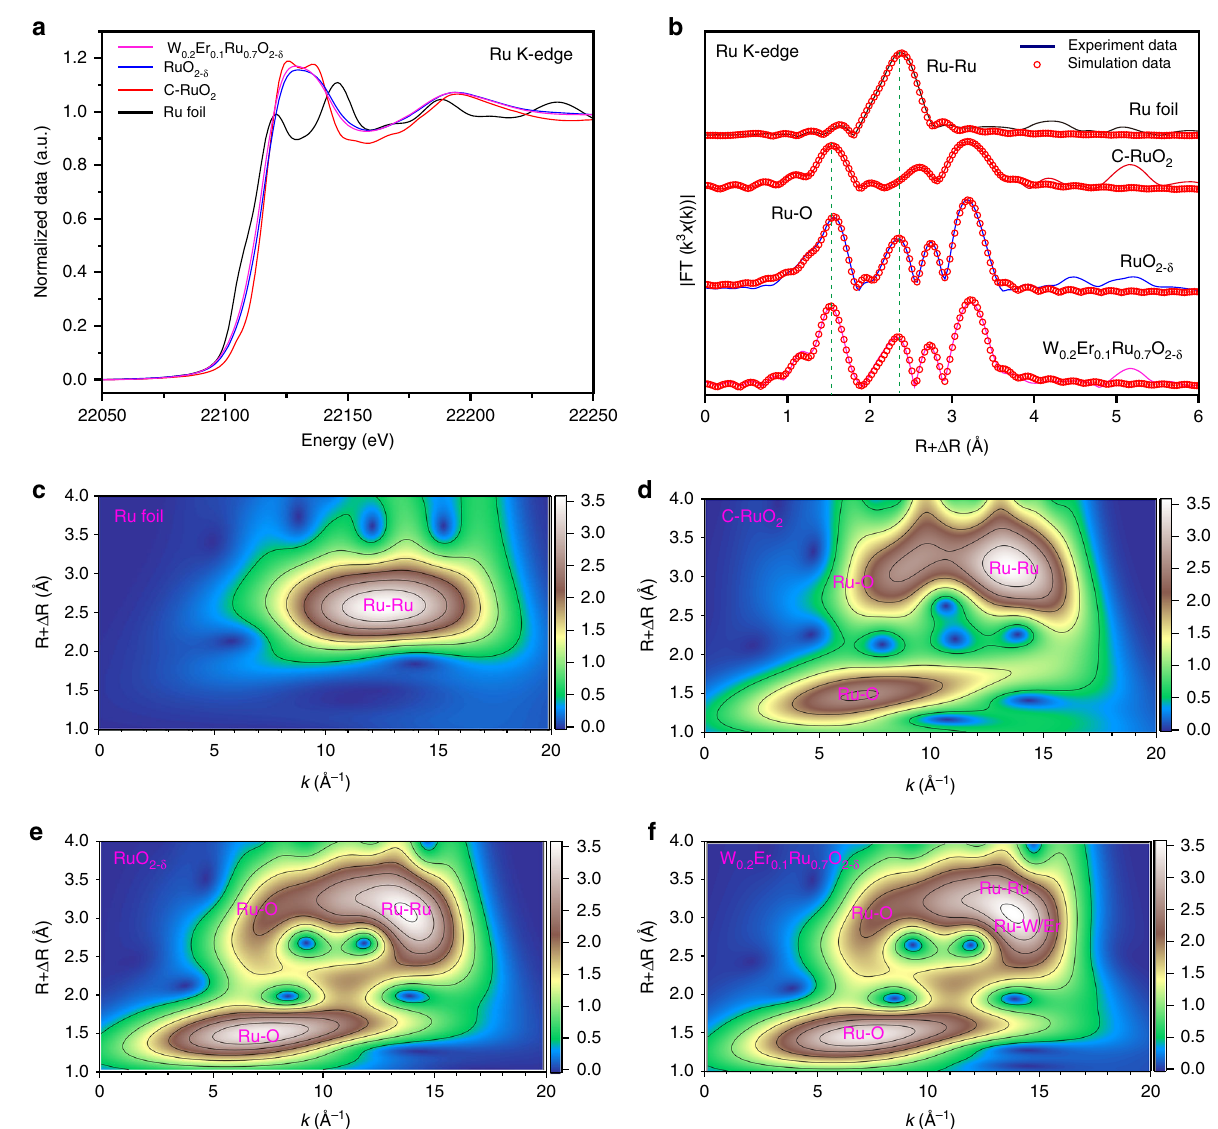
Fig. 5 XANES characterization for W 0.2 Er 0.1 Ru 0.7 O 2 − δ and RuO 2 − δ nanosheets. a Ru K-edge spectra for Ru foil, C-RuO 2 , W 0.2 Er 0.1 Ru 0.7 O 2 − δ , and RuO 2 − δ . b FT-EXAFS spectra of Ru K-edge for Ru foil,